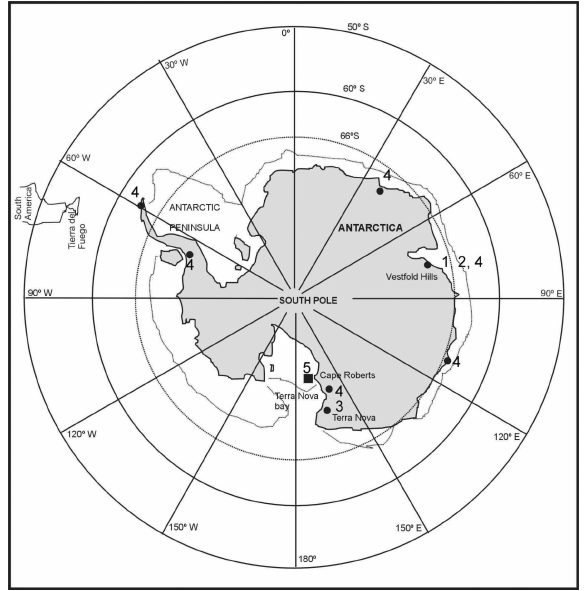
F IG . 2. – Map of Antarctica showing the location of sites with Qua- ternary Mollusca: raised beaches are pointed out with black dots and drillcores with black squares. References: 1. Zhang et al ., 1983; 2. Pickard (1985); 3. Baroni and Orombelli (1991); 4. Berkman (1992); 5. Taviani et al .